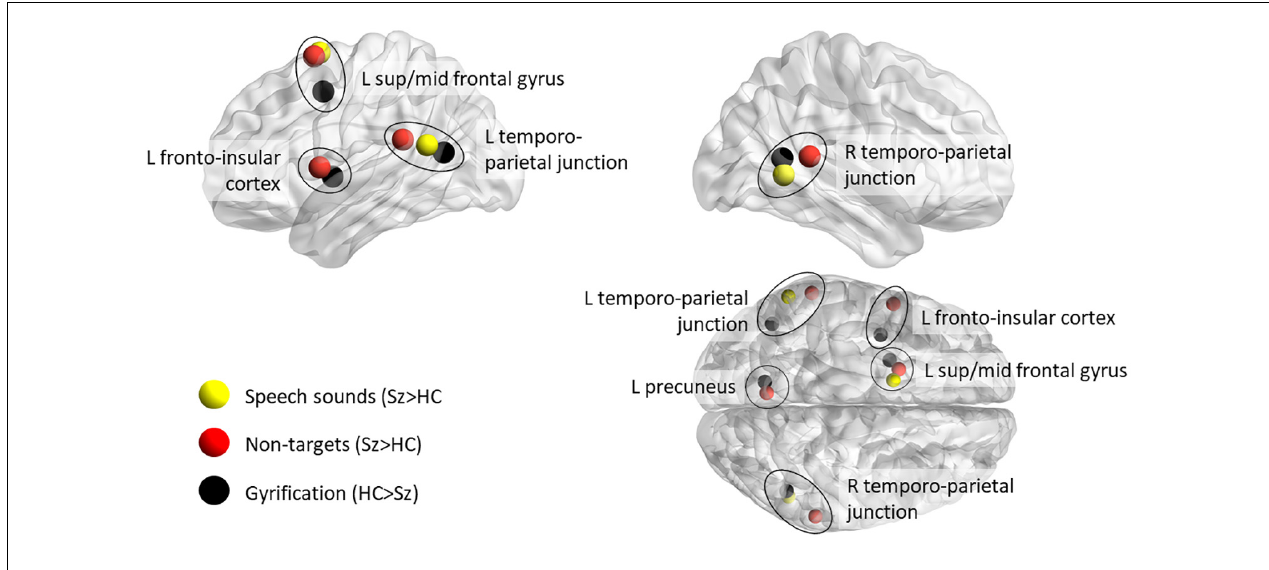
FIGURE 1 | Comparison of regions of aberrant increase of brain activity in patients with schizophrenia during tasks likely to involve endogenous coding of predictions, with the regions in which local gyrification index is diminished in patients relative to healthy controls. Red spheres depict the loci of local maxima in clusters of voxels exhibiting greater activity in patients with schizophrenia relative to healthy controls during processing of non-target stimuli in a target detection task (Liddle et al., 2013); yellow spheres depict local maxima of aberrant activity in patients during processing of word sounds relative to non-word sounds (Ngan et al., 2003). The black spheres depict the local maxima in clusters of reduced local gyrification in schizophrenia compared with healthy controls (Palaniyappan and Liddle, 2012). Note that the clusters were irregular is shape and many extended beyond the sphere depicting the local maximum. In particular, the region of diminished gyrification with peak difference between patients and controls in the left middle frontal gyrus extended into superior frontal gyrus. The brain loci were visualized using Brain Net Viewer (Xia et al., 2013).